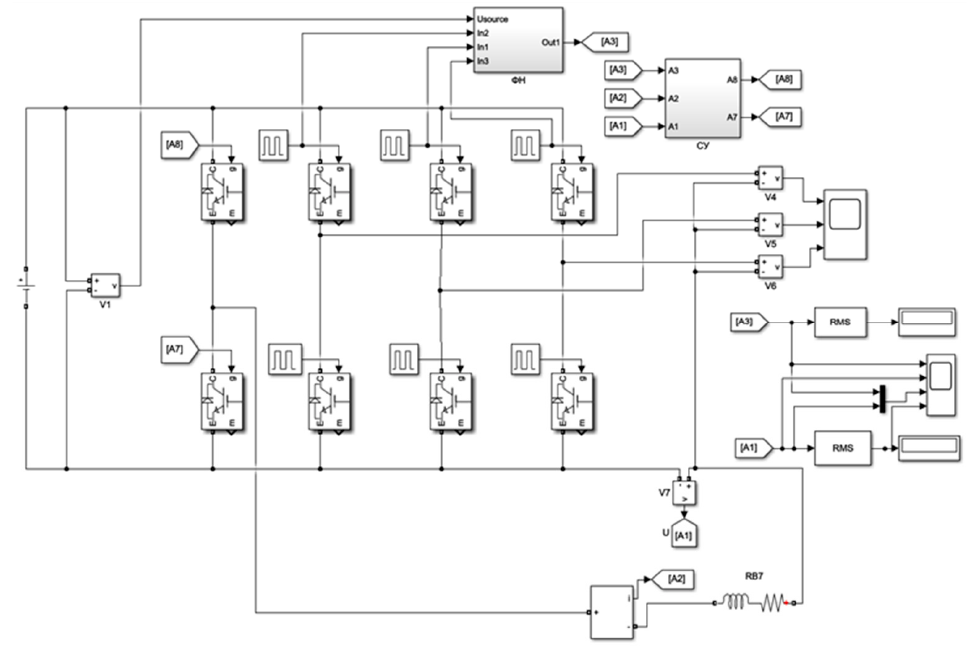
Figure 9. The model of the symmetry device based on the PI controller in MATLAB/Simulink [41]. In order to verify the effectiveness of the proposed voltage symmetry system for